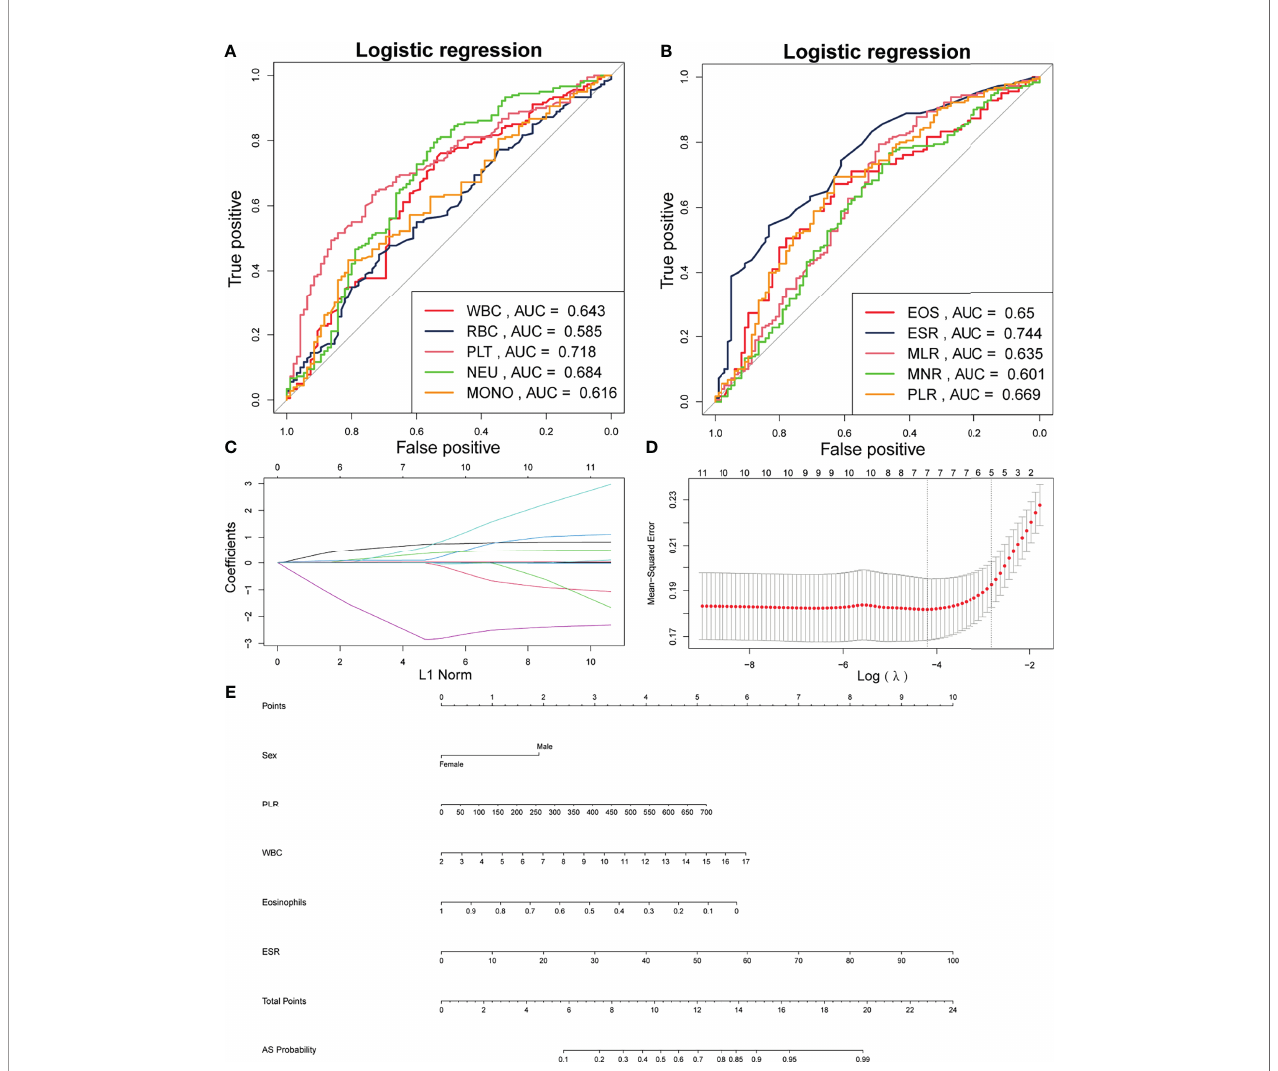
FIGURE 1 | Establishment of a nomogram for AS. (A) AUCs of the fi ve factors. (B) AUCs of the other fi ve factors. (C) Using 1000-fold cross-validation to the optimal penalty parameter lambda. (D) LASSO coef fi cient pro fi les of the 5 characteristics. (E) Nomogram for predicting AS